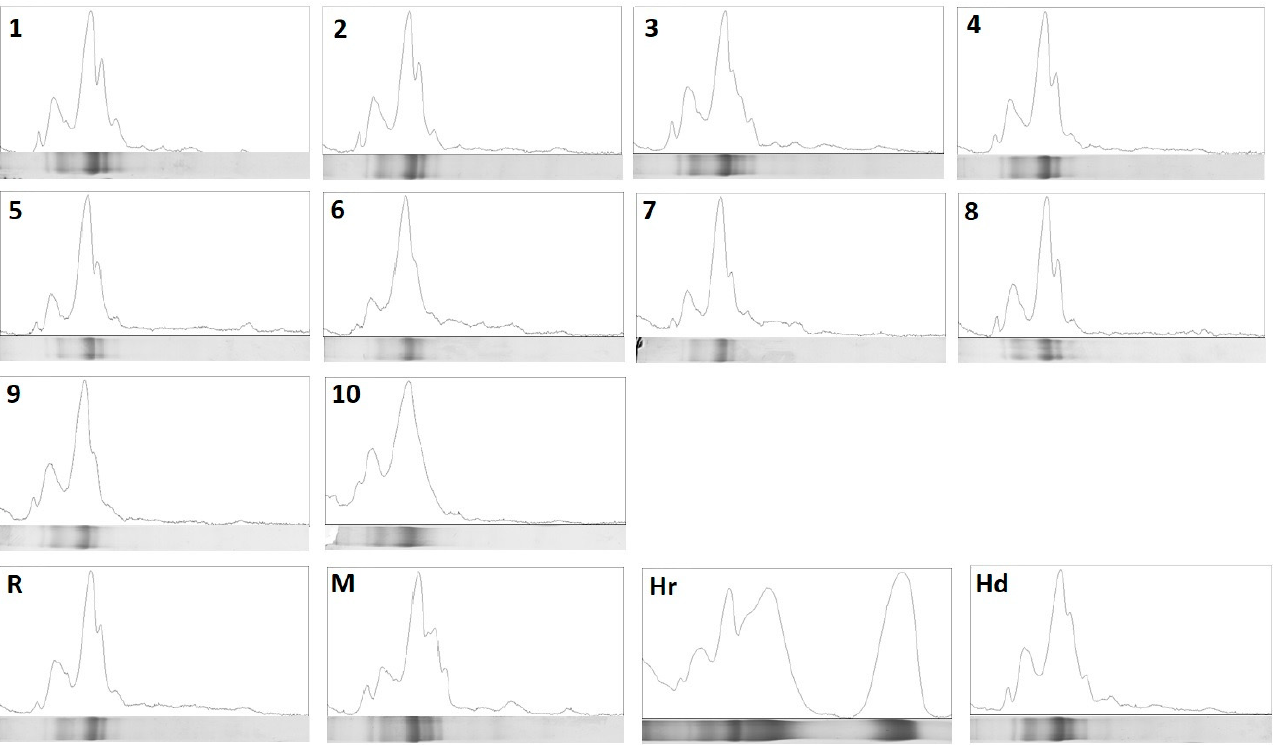
Figure 3. Detailed analysis of particular SDS-PAGE protein profiles obtained for analyzed goldenrod honeys (1–10) and four reference honeys (Hr—heather, Hd—honeydew, R—rapeseed, M—multifloral) in ImageJ software.